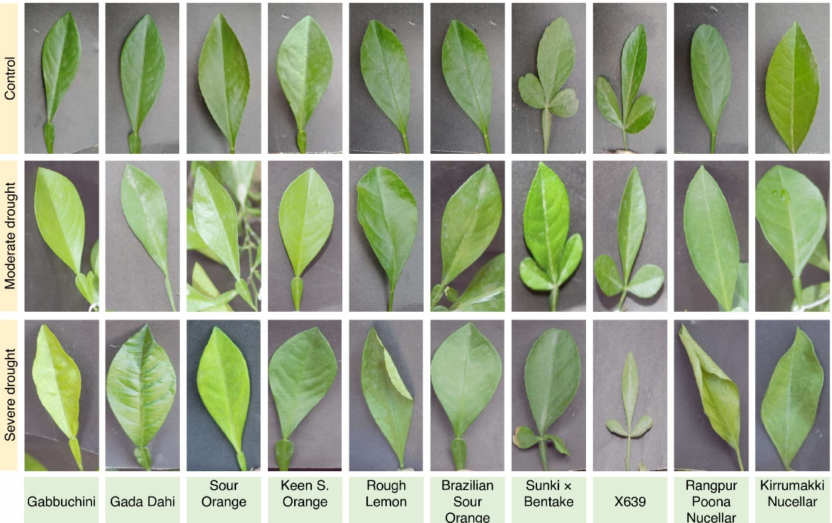
Figure 1. Effect of different water regimes on the leaf phenotype of 10 different citrus rootstocks with distinct degrees of tolerance to drought